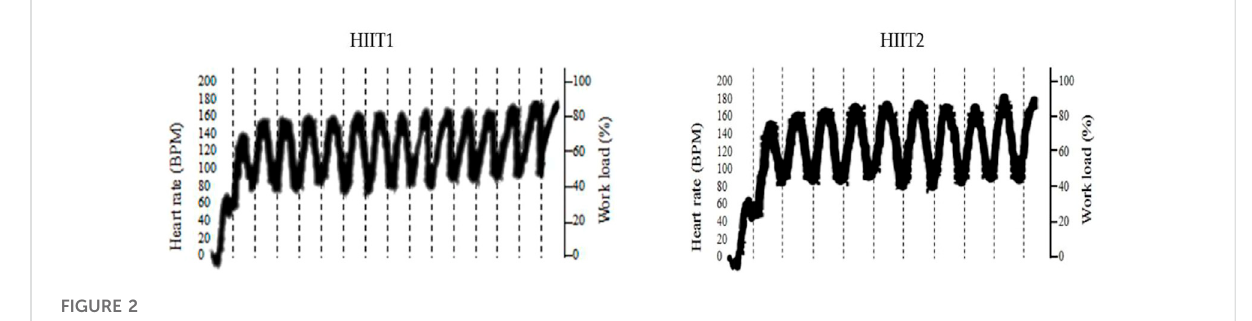
FIGURE 2 Heart rate monitor during two HIIT protocols period.